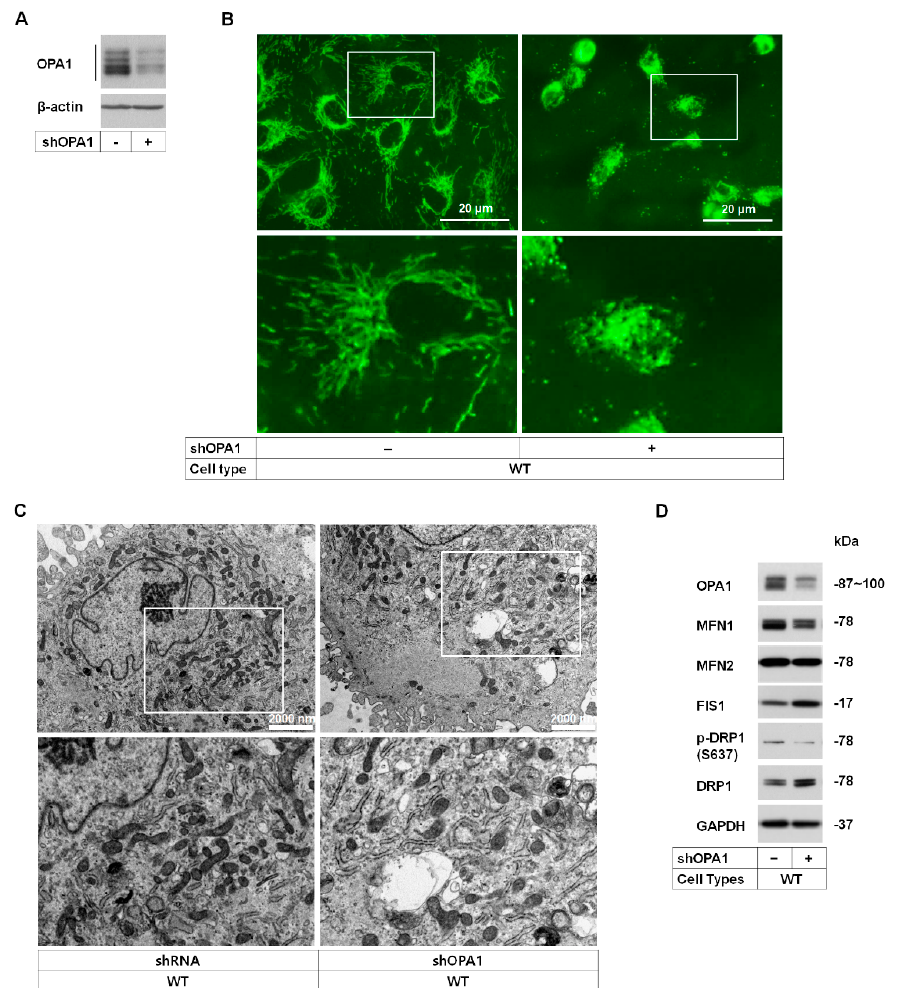
Figure 3. Knockdown of OPA1 leads to mitochondrial ultrastructural abnormalities and differential fusion/fission ‐ related protein levels. ( A ) Expression levels of OPA1 in scrambled shRNA ( ‐ ) and OPA1 ‐ specific shRNA ‐ expressing (+) in corneal fibroblasts. β‐ actin was used as the loading control. ( B ) Confocal images of scrambled shRNA ( − ) and OPA1 ‐ specific shRNA ‐ expressing (+) in WT corneal fibroblasts stained with MitoTracker Green. White boxes in upper panels show corneal fibroblasts, which are magnified in lower panels. Scale bars, 5 μ m. ( C ) Representative EM images of mitochondrial ultra ‐ structures of shRNA and shOPA1 in corneal fibroblasts. White boxes in upper panels show mitochondria of shRNA (left) and shOPA1 in WT corneal fibroblasts, which are magnified in lower panels. ( D ) Western blot analysis of the levels of fusion/fission ‐ related proteins in OPA1 ‐ KD corneal fibroblasts.